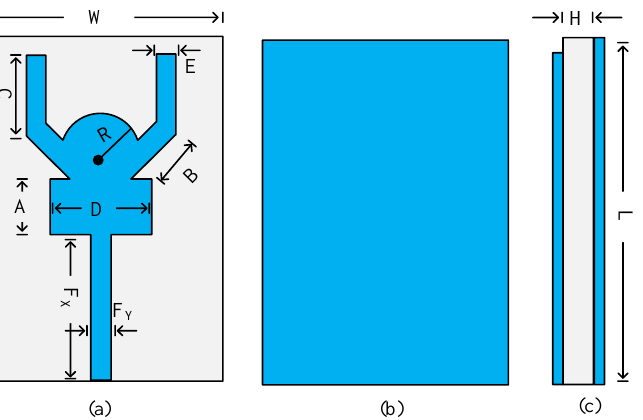
Figure 1. Geometrical configuration of proposed a dual-band millimeter wave antenna: ( a ) top view, ( b ) back view, and ( c ) side view.